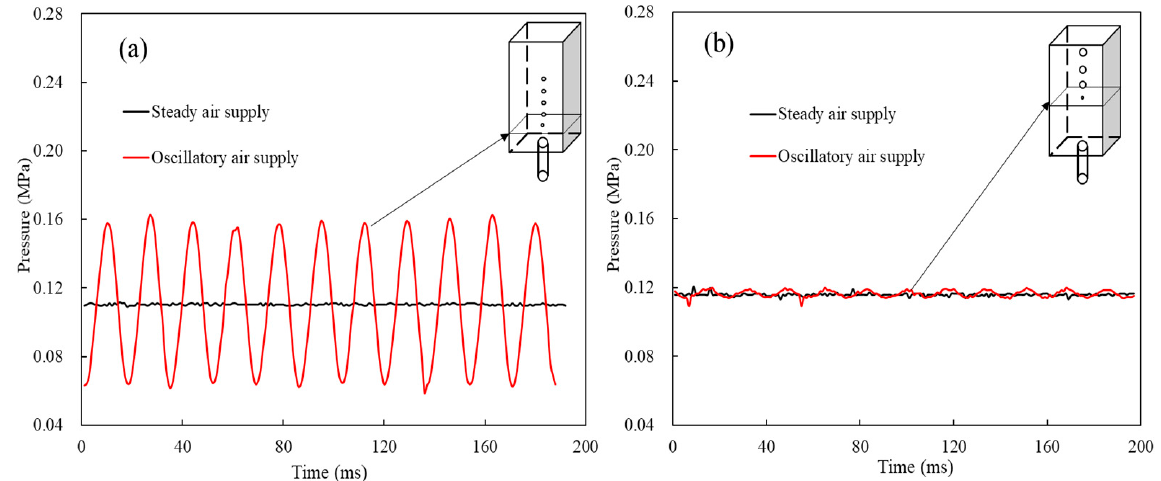
Figure 6. Air pressure at the orifice outlet for different chamber volumes with steady ( a ) and oscillatory ( b ) air patterns.